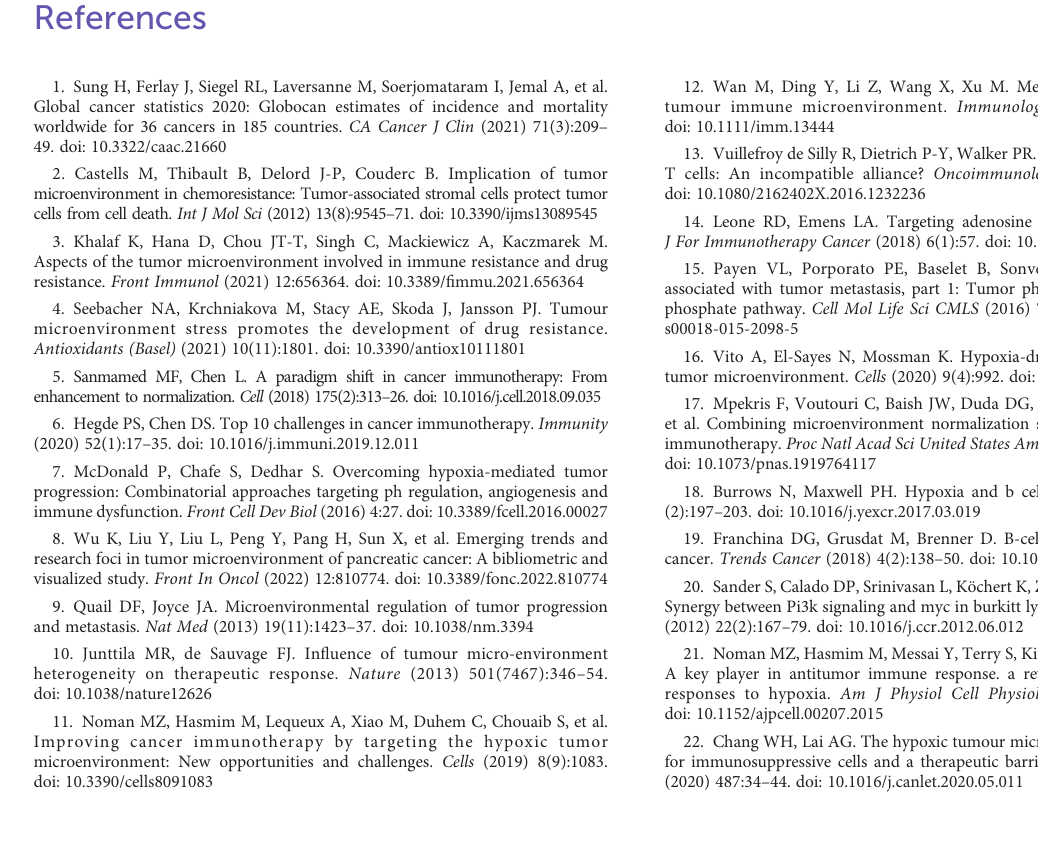
table: GC, KW, HL. (IV) Final approval of manuscript: All